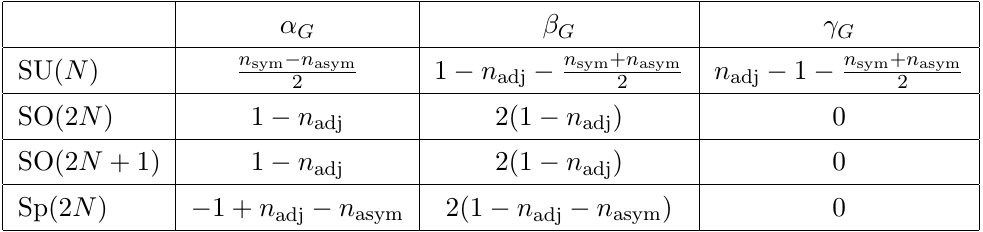
Table 1 . Value of the coe(cid:14)cients in (2.8) for the di(cid:11)erent Lie